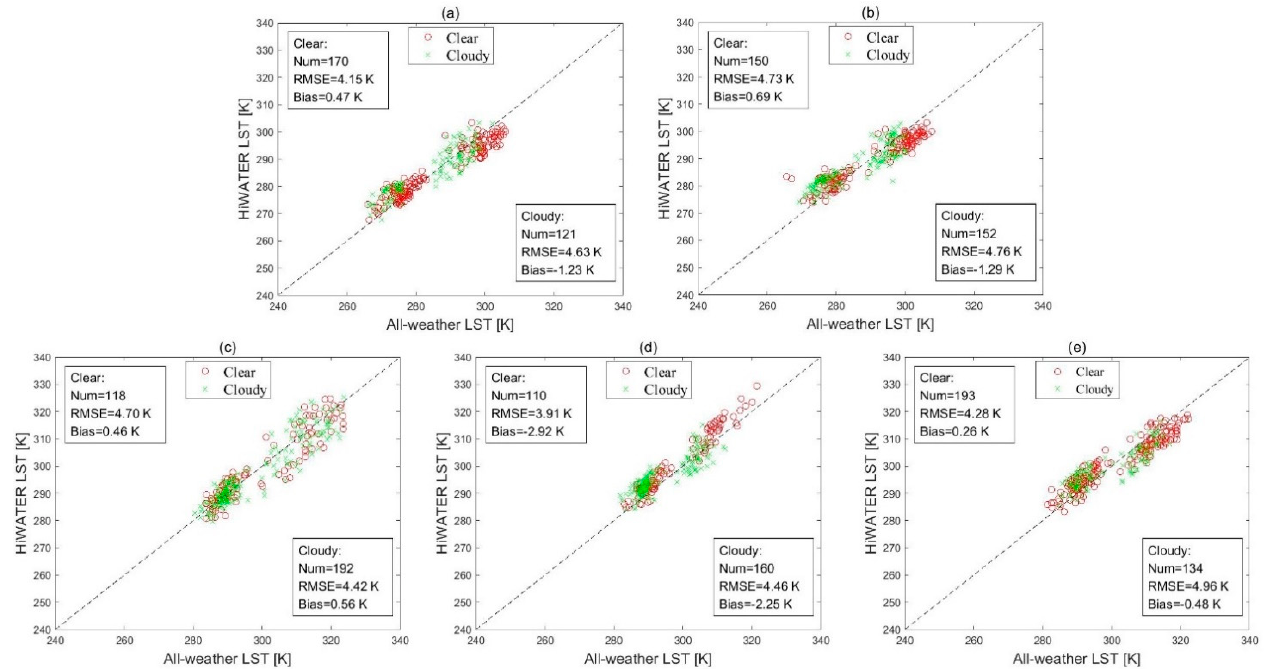
Figure 11. Scatterplots of the all-weather MODIS LST against the ground-measured LST at 5 HiWATER sites: ( a ) DSL; ( b ) AR; ( c ) HZZ; ( d ) HH, and ( e ) SDL in 2018.